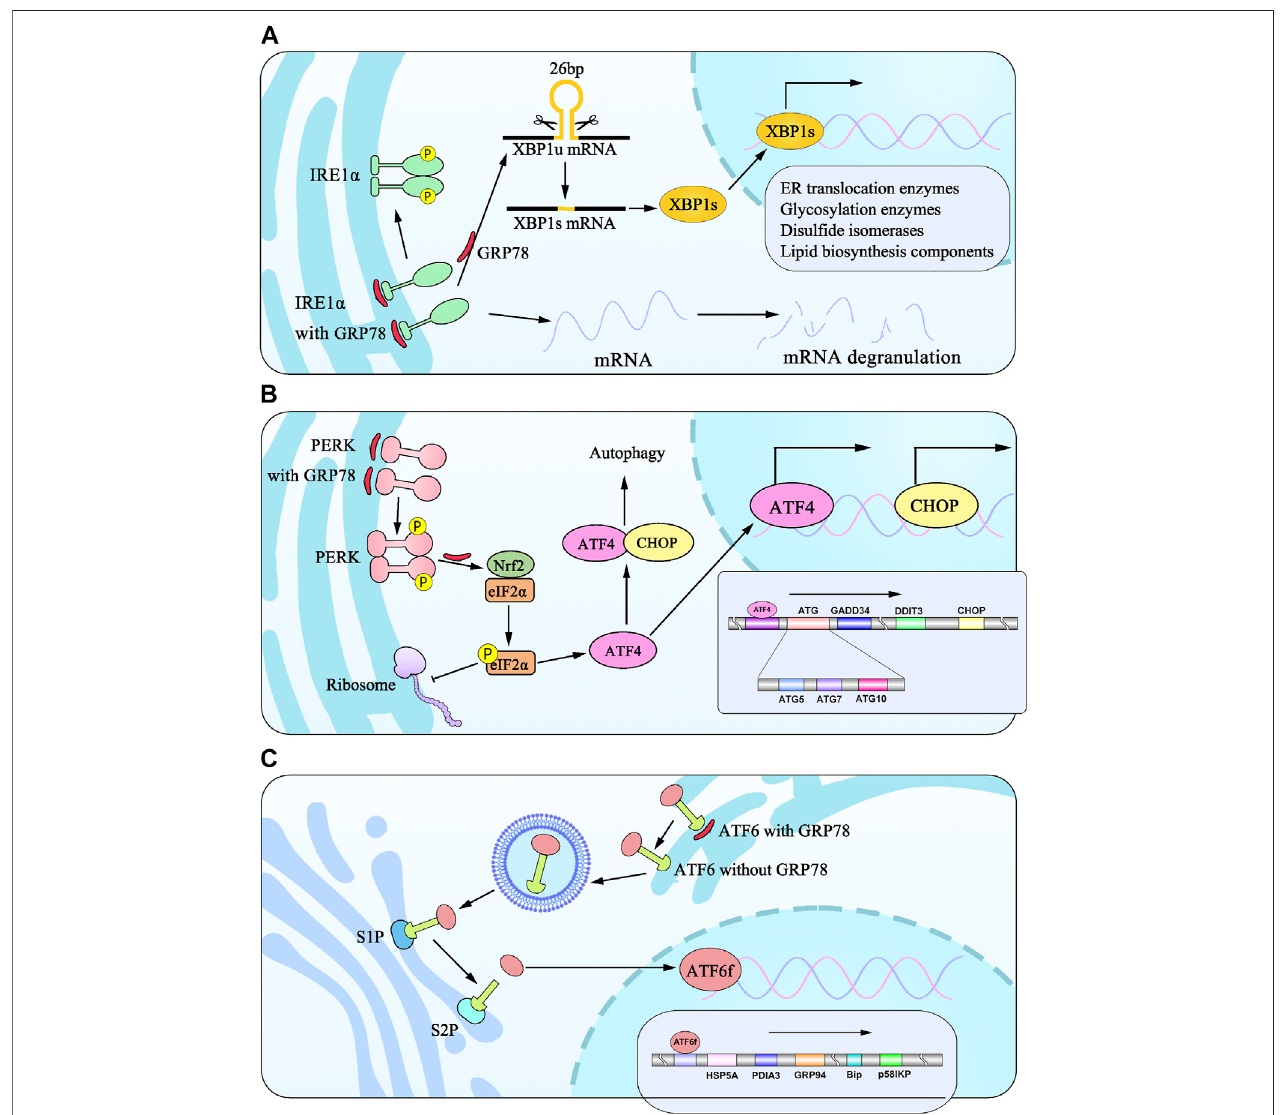
FIGURE 1 | Model diagram of signaling pathways from three ER transmembrane stress sensors during UPR induced by ER stress. (A) IRE1 α isolates from BiP undergo dimerization and phosphorylation to splice 26bp from XBP1 into XBP1s, which translocates to the nucleus and induces the transcription of target genes. (B) PERK signaling is initiated through PERK dimerization and autophosphorylation of the cytosolic PERK kinase domain. eIF2 α phosphorylation is elicited to attenuate global protein synthesis. eIF2 α promotes translation of ATF4, which translocates to the nucleus to regulate the expression of target genes and cooperates with CHOPtoparticipate inERstress-induced apoptosispathways. (C) ATF6dislocatesfromBiPtranslocatestoGolgiapparatus,whichiscleaved byproteases atS1Pand S2P sites into ATF6f and promotes the transcription of genes.